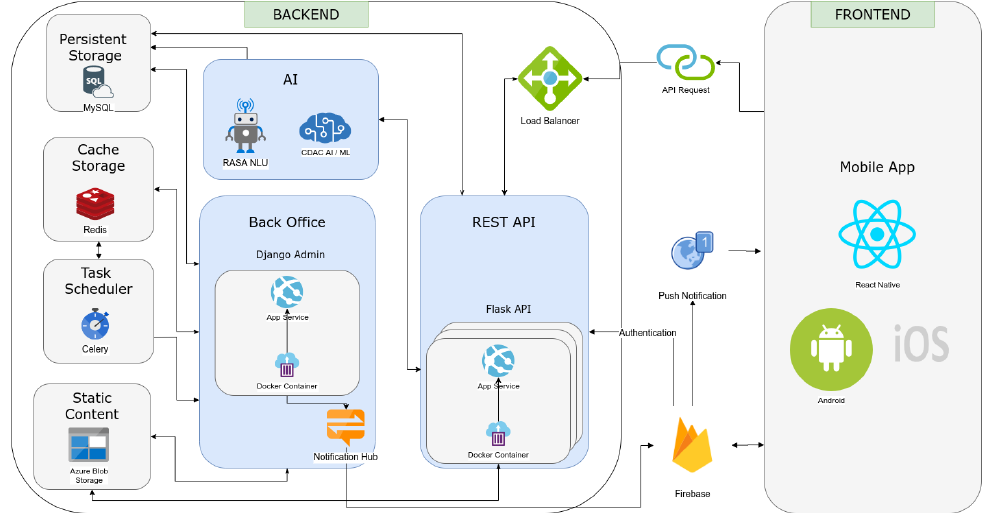
Figure 6. Technical architecture of the BA-based AI chatbot, which is implemented as a smartphone application on both Android and iOS operating